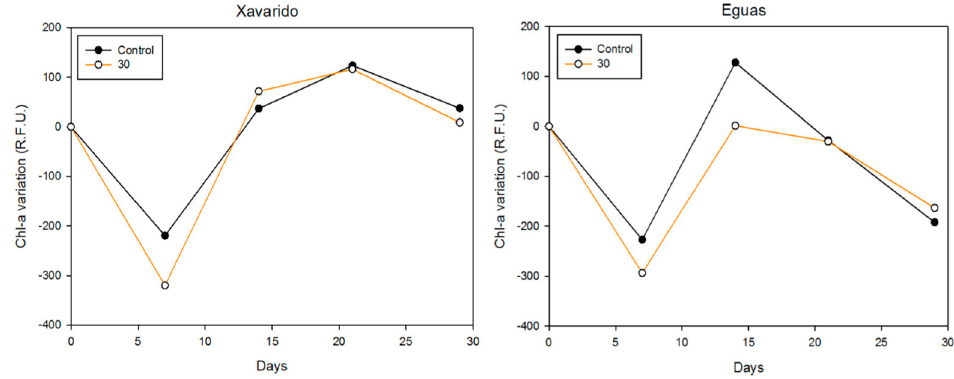
Figure 7. Biofilm growth in the experiment 2, measured by Chl-a fluorescence (R.F.U.).